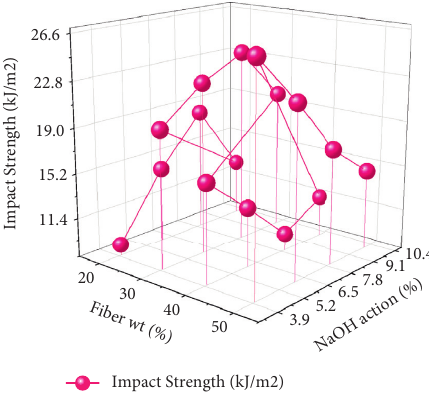
Figure 15: Impact strength: 3D trajectory plot of fiber weight percentage and NaOH action.